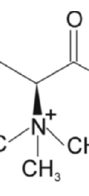
Figure 5. Chemical structure of ergothioneine.